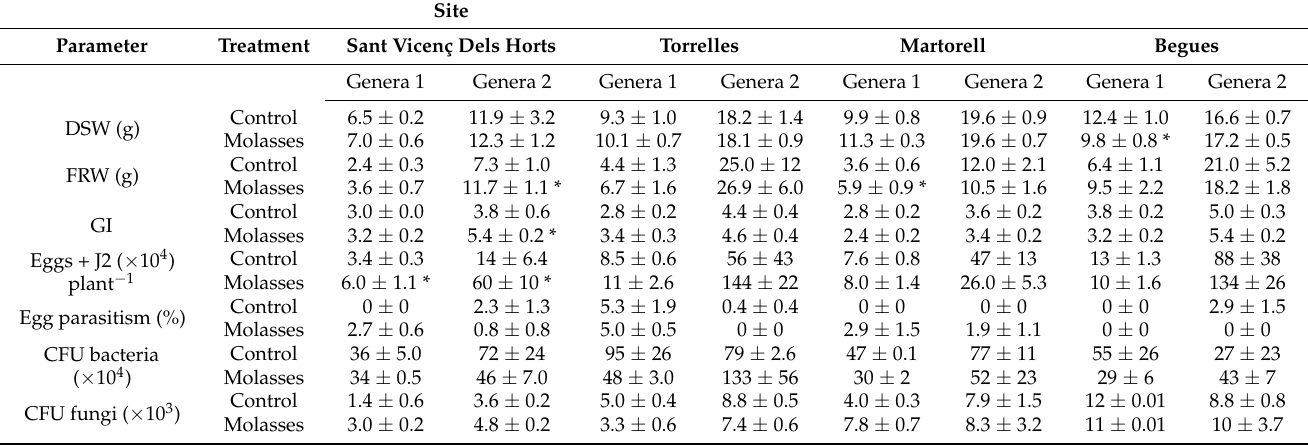
Table 2. Effect of 1 mL m − 2 of molasses application at transplanting the tomato cv. Durinta and after 19 and 45 days of cultivation on the plant dry shoot weight (DSW), fresh root weight (FRW), galling index (GI), number of eggs + J2 per plant, egg parasitism (%), and soil bacterial and fungal density (CFU) after the completion of 1 and 2 nematode generations in 3 L pots with a soil mixture (soil from the organic fields and sterile river sand 1:1 (v:v)) infested with 1 J2 of M. incognita cm − 3 of soil, maintained in a